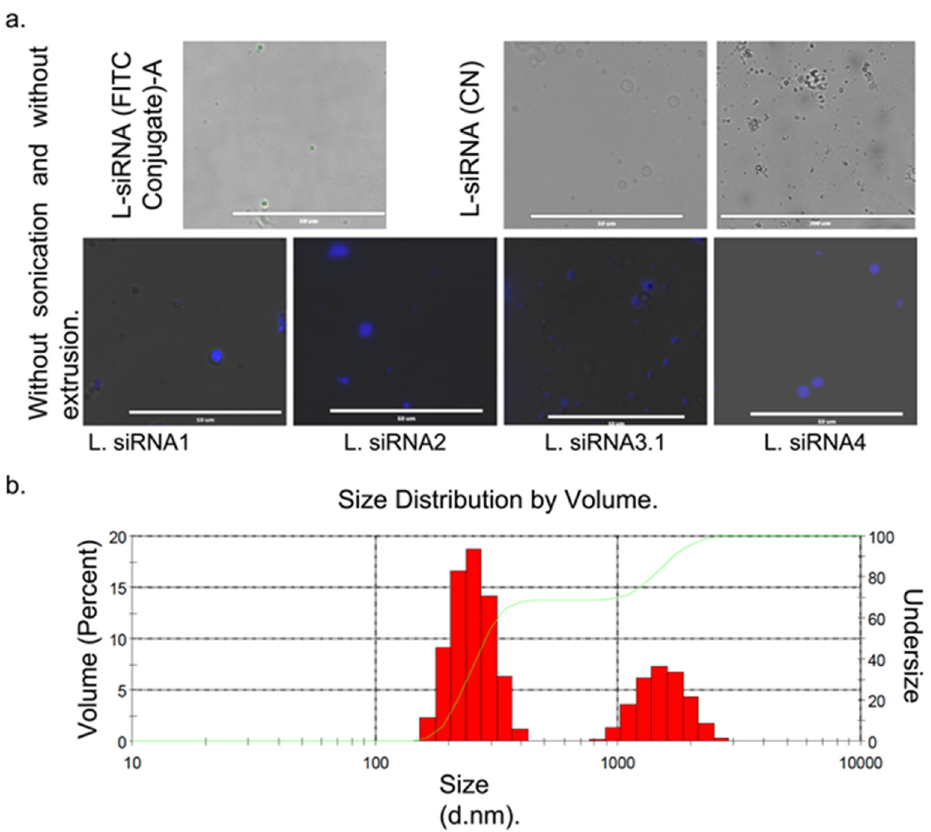
Figure 2. Characteristic sizes of liposomes with siRNA were obtained by fluorescent microscopy and dynamic light scattering (DLS). ( a ) liposomes with siRNA without reduction in multilamellar size. Upper left row liposomes fluorescing in green due to the L-siRNA (FITC Conjugate)-A. Right L-siRNA (CN). Lower row liposomes with siRNA against each DENV serotype treated with Hoechst. ( b ) The mean size distribution of the L-siRNA is given in diameter values in nanometers (d.nm) through DLS.